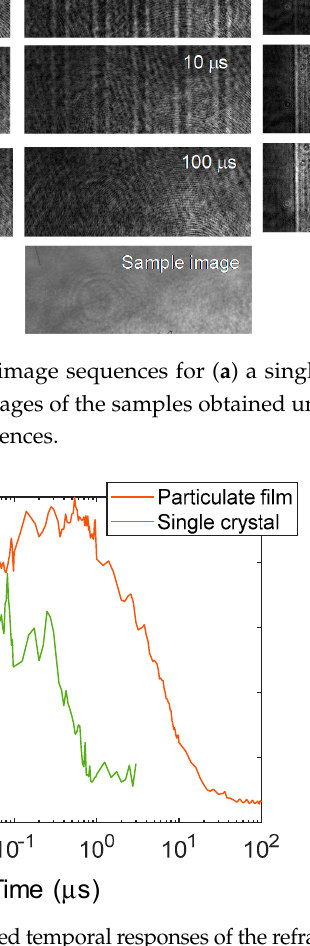
Figure 1. The PI-PM image sequences for ( a ) a single crystal and ( b ) a particulate TiO 2 film are shown. The optical images of the samples obtained under the same optical setup are also shown at the bottom of the sequences.